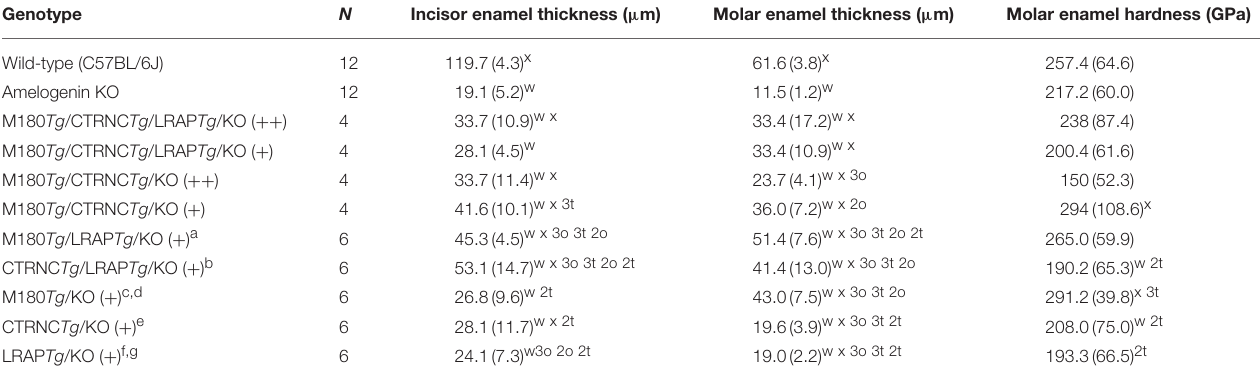
TABLE 3 | Enamel thickness and hardness of adult mandibular molars and incisors.